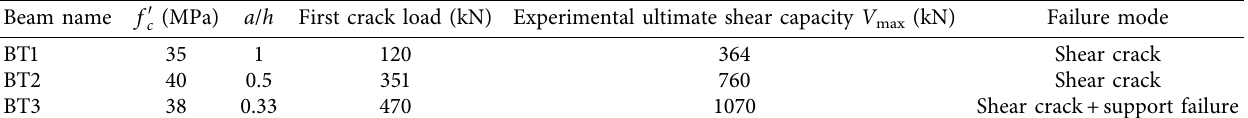
Figure 3: The cracked form of specimens. (a) BT1. (b) BT2. (c) BT3. Table 3: Specifications of experimental specimens.